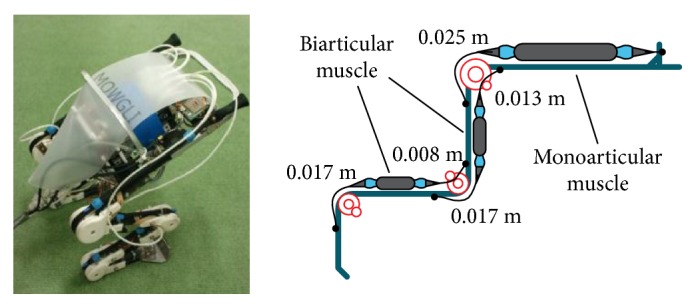
Jumping robot Mowgli [30].